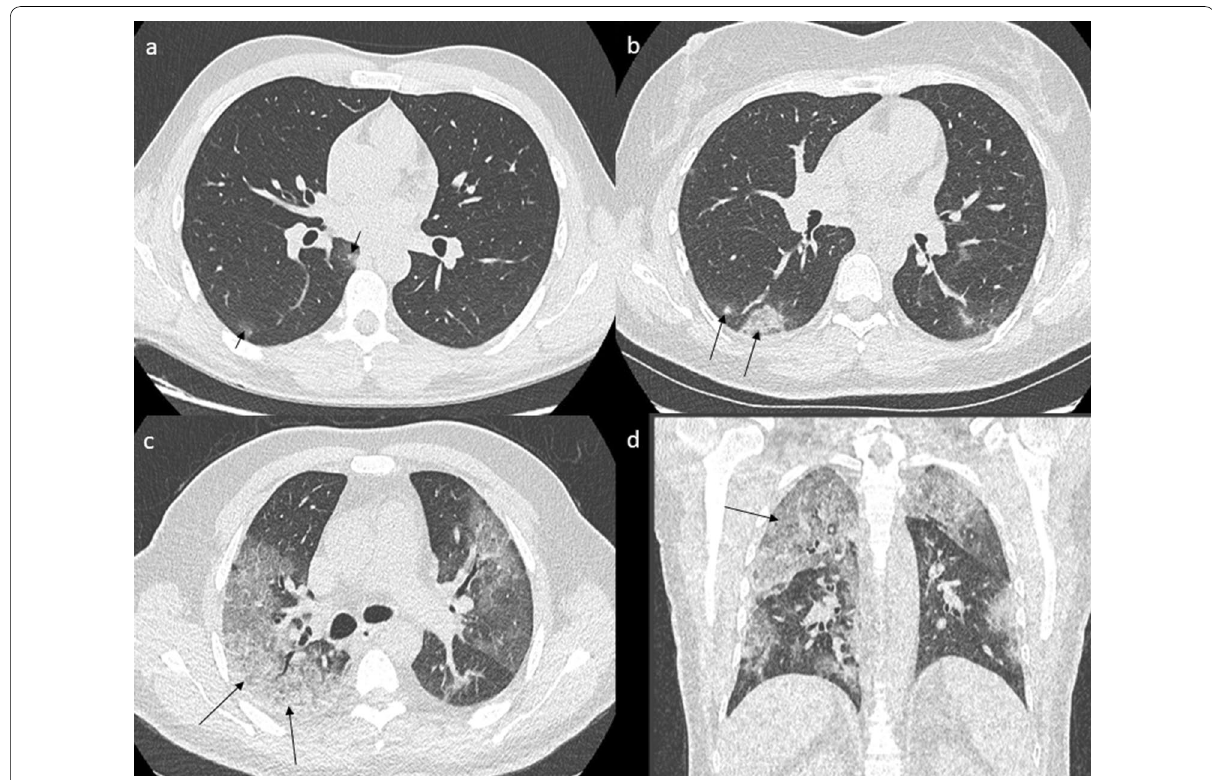
Fig. 1 CT‑SS, instances of different involvements. Note: a A 27‑year‑old male COVID‑19 patient with no medical history presenting cough, anosmia and fever for 4 days. LDCT shows two GGOs in the right 6th segment (arrow) corresponding to a minimal impairment with the presence of < 10 secondary lobules. The global CT‑SS was 1. b A 44‑year‑old female COVID‑19 patient with no medical history presenting cough, rhinorrhea and myalgia for 5 days. LDCT shows GGO in the right 6th segment (arrow) corresponding to an intermediate impairment with the presence of < 50% involvement of the 6th segment. The global CT‑SS was 4. c , d A 65‑year‑old male COVID‑19 patient with diabetes and hypertension presenting cough, rhinorrhea, anosmia, myalgia and dyspnea for 7 days. LDCT shows GGO and partial consolidation in the right 2nd segment (arrows), corresponding to severe impairment with more than 50% involvement of the segment. The global CT‑SS was